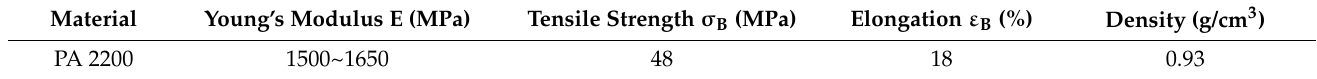
Figure 2. Photograph of sample specimen (C4). Table 1. Material properties of polyamide [27].